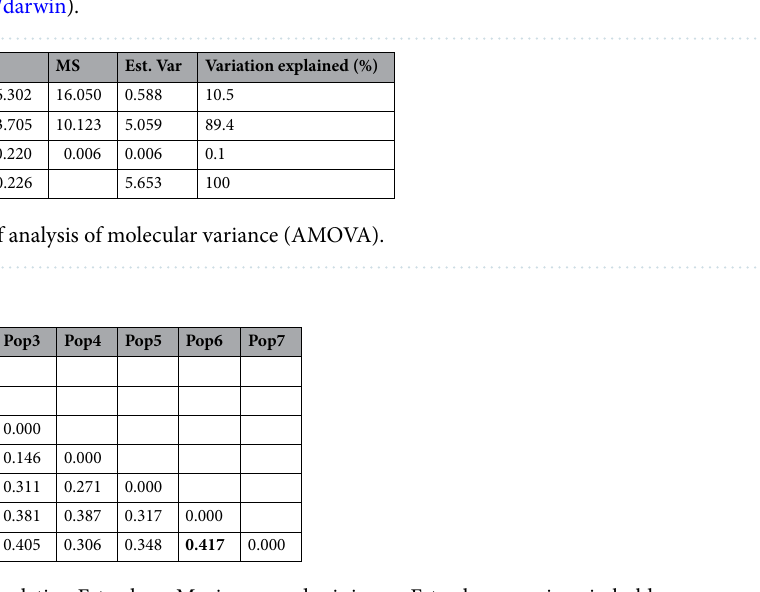
Table 4. Pairwise population Fst values. Maximum and minimum Fst values are given in